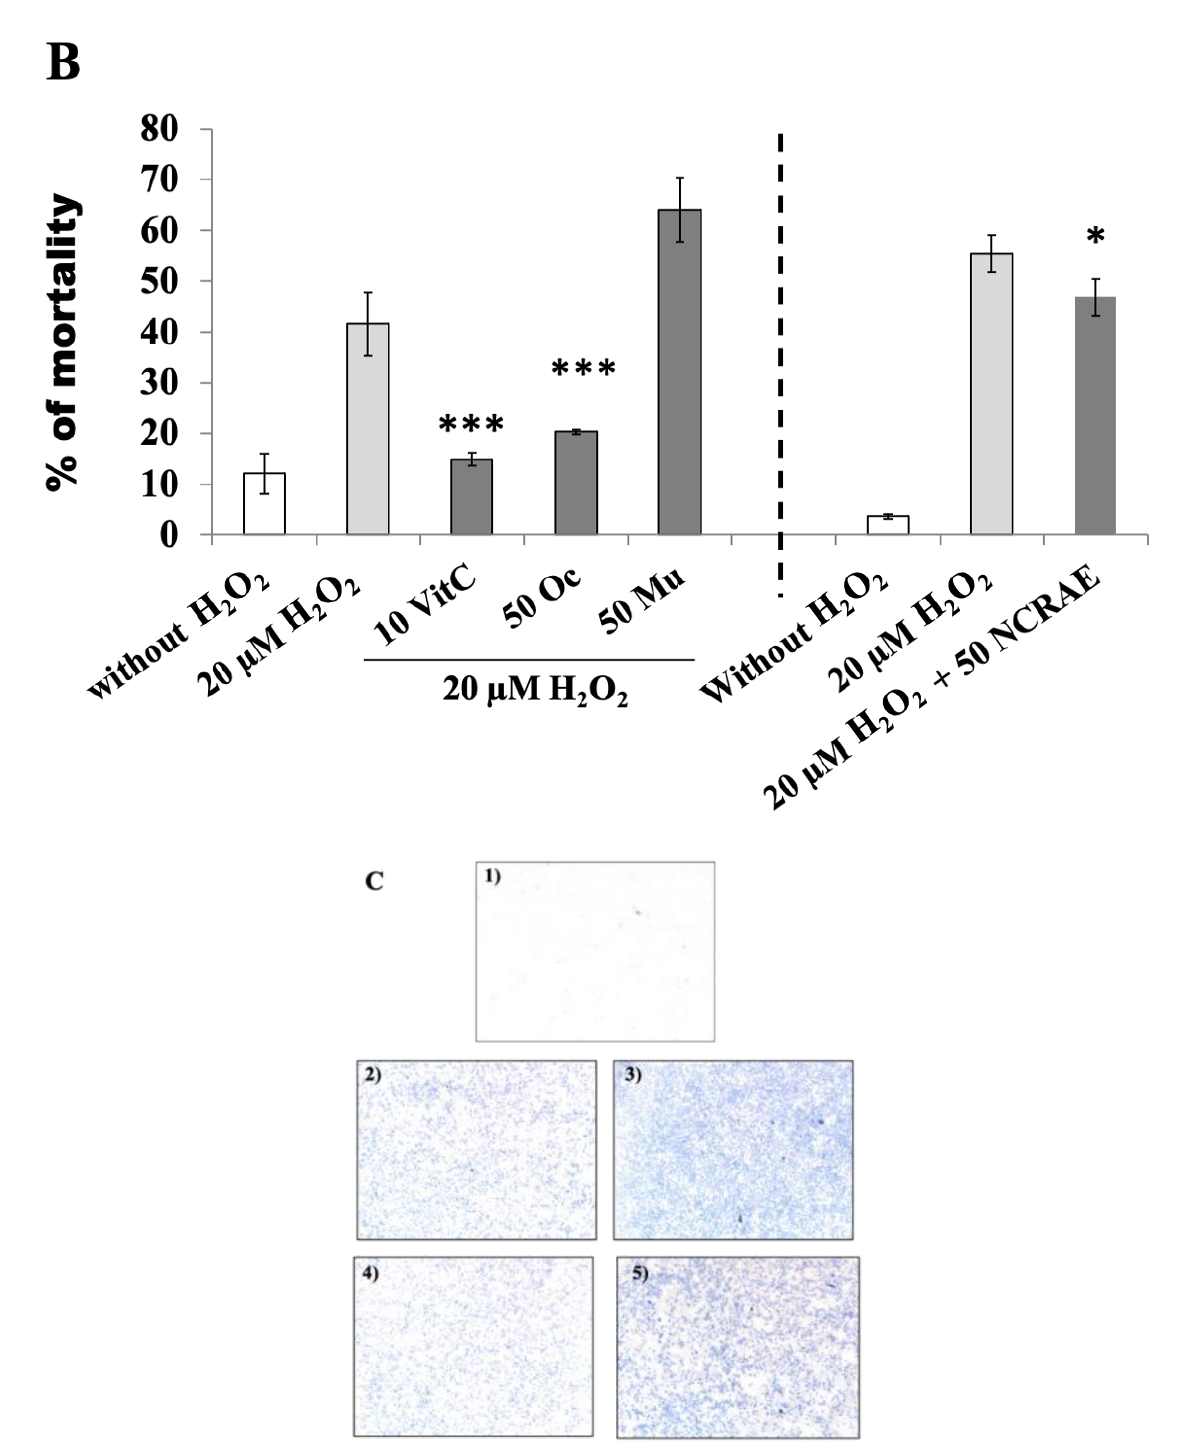
Figure 4. Modulation of the glucose 6-phosphatase activity and H 2 O 2 oxidative stress effects of Oc extract or Mu extract (50 µg·mL −1 ). ( A ) Glucose 6-phosphatase activity on hepatic microsomes in presence of Oc and Mu extracts. Comparison with NCRAE as reference extract and chlorogenic acid (CGA) as positive control. Values are the means (±SD) of three independent experiments (* p < 0.05). ( B ) Percentage of mortality induced in L6 muscle cells by H 2 O 2 oxidative stress. Comparison with NCRAE (reference extract) at 50 µg·mL −1 and vitamin C (Vit C) as positive control. Values are the means (±SD) of six independent tests (* p < 0.05, and *** p < 0.001). ( C ) Images of L6 cells mortality after H 2 O 2 oxidative stress exposure, objectivized by trypan-blue staining. (1) Control without H 2 O 2 ; (2) with 20 µM H 2 O 2 ; (3) with 60 µM H 2 O 2 ; (4) Oc pretreatment and 20 µM H 2 O 2 ; (5) Mu pretreatment and 20 µM H 2 O 2 .